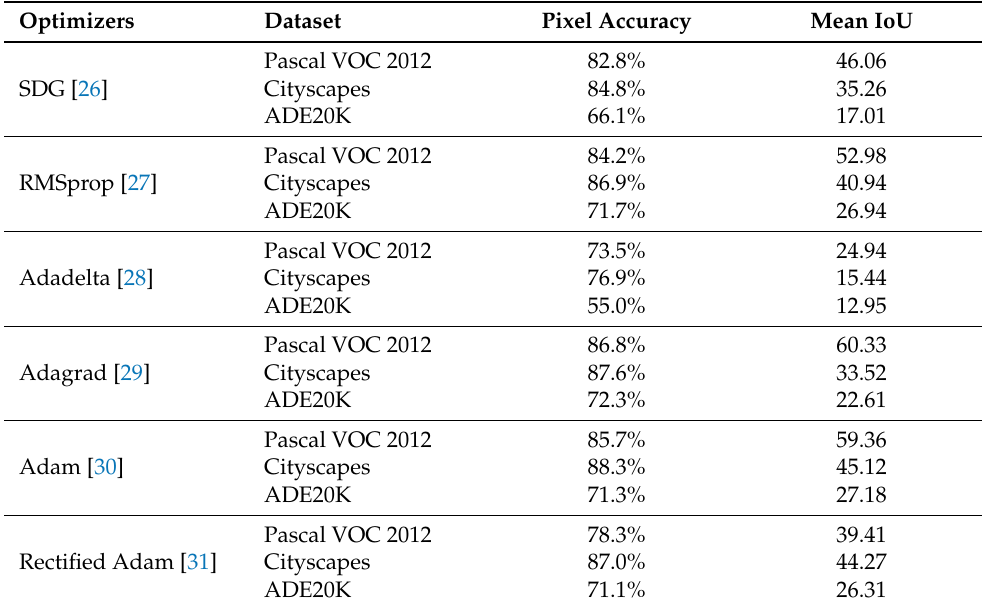
Table 10. The network’s performance when being trained with different optimizers (run three times, the values shown are the